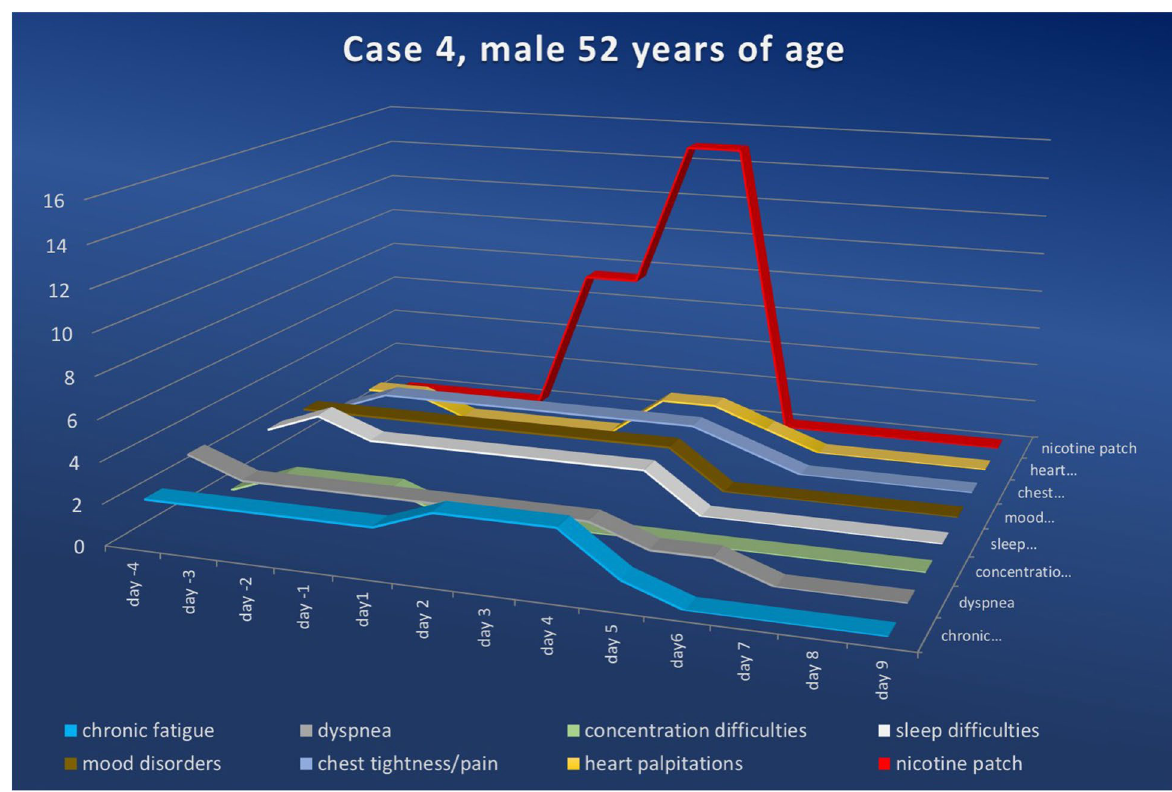
Fig. 6 Symptom score for case 4 ranging from the fourth day prior to and to the tenth day after nicotine administration (fourth symptom-free day). Upon nicotine treatment, the symptom scores in all categories fell continuously. The numerical value in the ordinate shows the value of the symptom score, while the nicotine dosage for the amount delivered per 24 h is shown in red